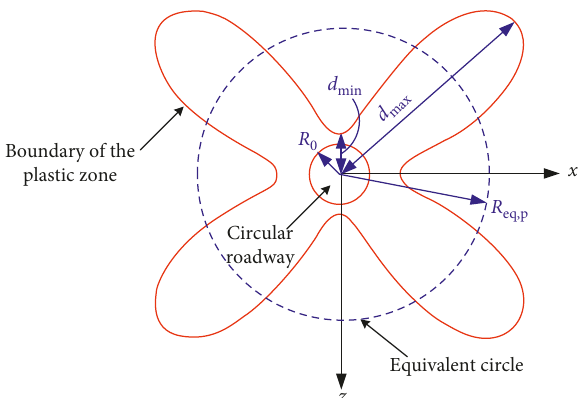
Figure 9: The equivalence of the plastic zone and the geometric parameters.